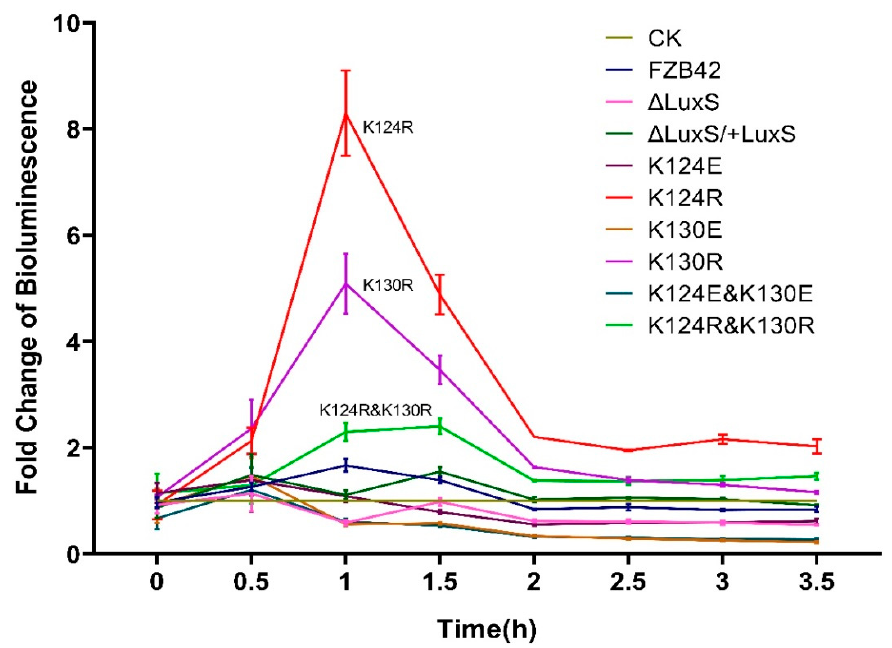
Figure 5. Induction of bioluminescence in V. harveyi (BB170) by cell-free supernatants of FZB42 WT and its LuxS mutants. At time zero, the supernatants were added to BB170 cultures at a final concentration of 10% ( vol/vol ), and light production was recorded. In the CK, only LB was added. Three replicates were performed for each treatment.